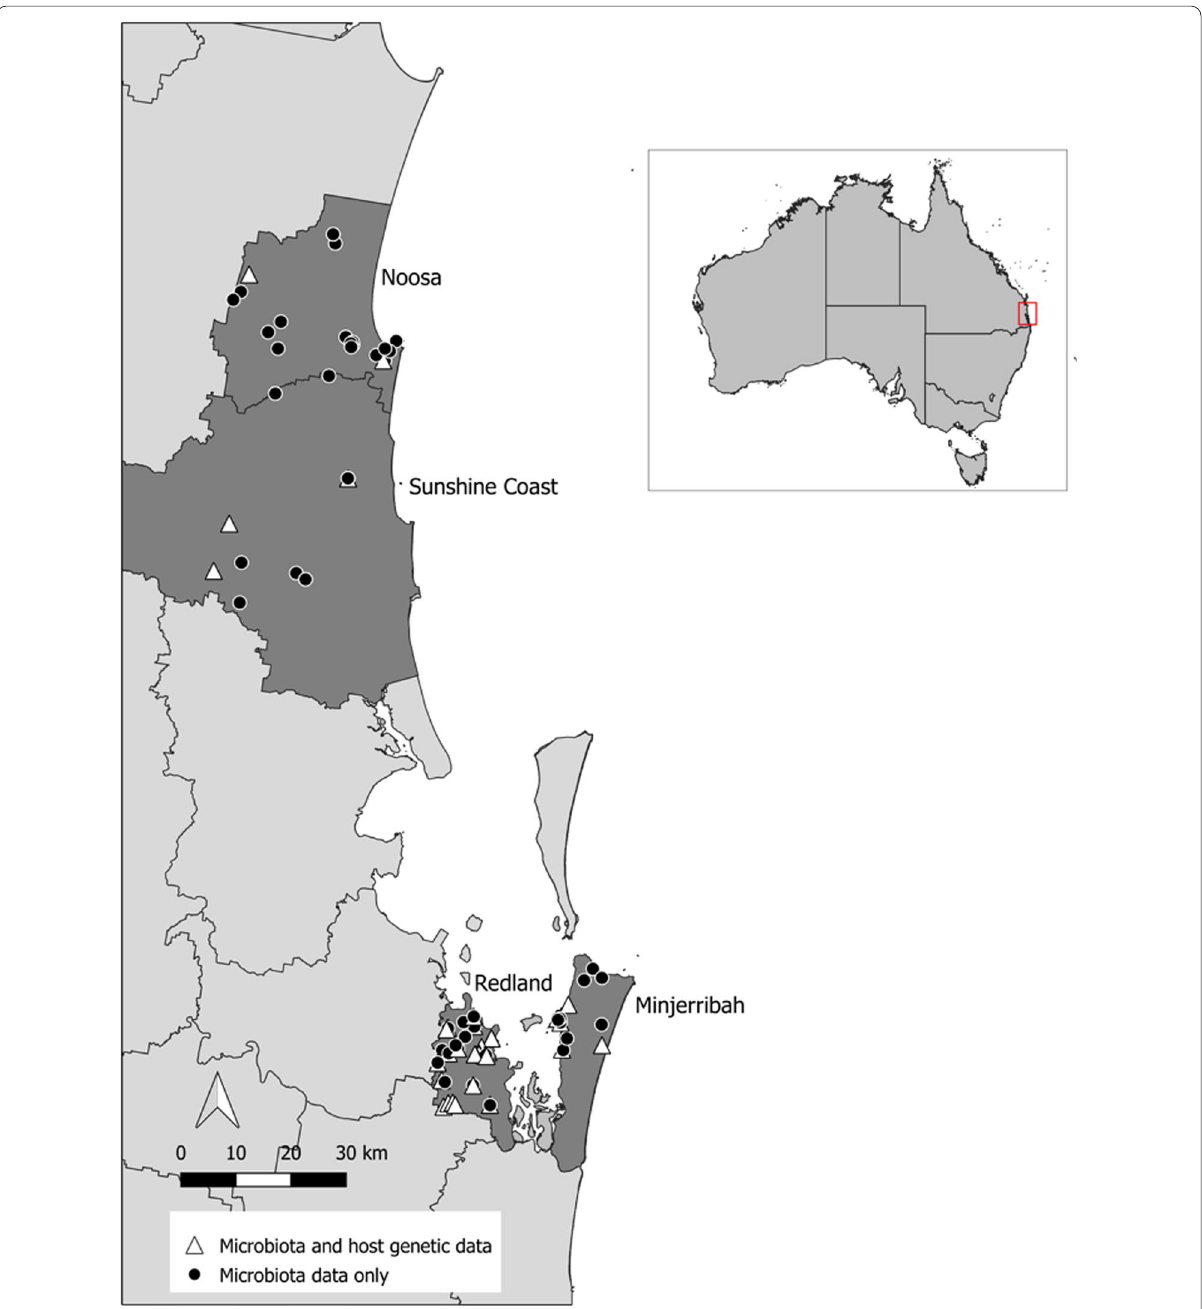
Fig. 1 Map showing all locations of scat samples (prior to filtering; n 96) collected across four locations in South East Queensland, Australia = (locations highlighted in dark grey with council borders outlined by black lines). White triangles represent samples which yielded microbiota and koala DNA data, black circles represent samples with microbiota data only. Please see Additional file 1: Figure S1 for fine‑scale maps outlining the number of overlapping samples in each